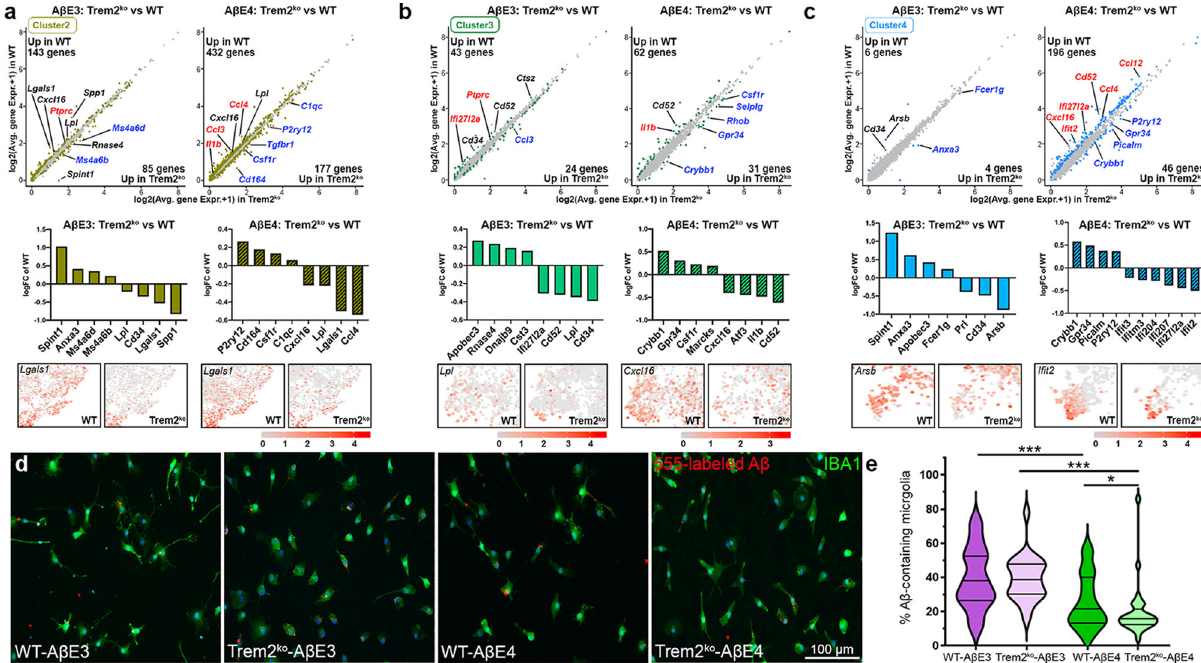
Fig. 7 Trem2 de fi ciency and APOE isoform affect microglia response to A β . a – c Scatter plots, bar plots, and feature plots showing the differentially expressed genes in microglia from WT and Trem2 ko mice injected with A β E4 or A β E3 complexes for cluster 2 ( a ), cluster 3 ( b ), and cluster 4 ( c ). Differentially expressend genes at p < 0.01 are colored in each cluster color. The adjusted P value was performed using Bonferroni correction. Genes labeled with black color indicate commonly up- or down-regulated genes in A β E3 or A β E4 injected mice. Genes labeled with red indicate uniquely upregulated genes in WT-A β E3 or WT-A β E4 and genes labeled blue is uniquely upregulated genes in Trem2 ko -A β E3 or Trem2 ko -A β E4. n = 2 mice per group (WT- A β E3, WT-A β E4, Trem2 ko -A β E3, and Trem2 ko -A β E4). d , e Microglia established from WT and Trem2 ko mice were treated with and 555-labeled A β for 1 h. d Representative images of microglia from WT and Trem2 ko mice incubated with A β E4 or A β E3 labeled with IBA1 in green and 555-labeled A β in red. e Bar plot showing the average percentage of A β -containing microglia for each group (WT-A β E3 purple, WT-A β E4, green, Trem2 ko -A β E3 light purple, and Trem2 ko -A β E4 light green). n = 3 independent cultures at least in triplicate. Analysis by one-way ANOVA followed by Tukey ’ s multiple comparison test. WT-A β E3 vs. WT-A β E4, p = 0.0008; Trem2 ko -A β E3 vs. Trem2 ko -A β E4, p < 0.0001; WT-A β E4 vs. Trem2 ko -A β E4, p = 0.0485. Violin plots represent kernel densities for each dataset showing median (middle line) and 75% (top) and 25% percentile (bottom). * p < 0.05; *** p < 0.001.